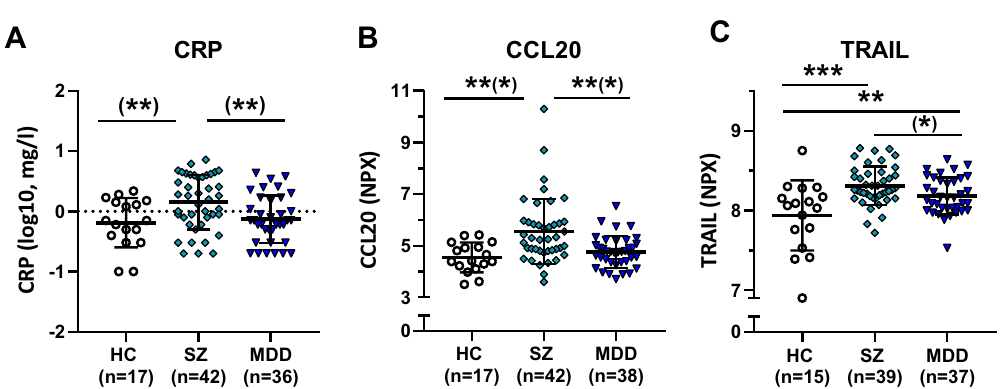
Figure 1. Group comparison of inflammatory markers. ( A ) CRP (log), ( B ) CCL20, ( C ) TRAIL. Units are mg/l for log10 (CRP), otherwise normalized protein expression (NPX) (an arbitrary unit on a log2-scale where a high value corresponds to a higher protein expression). HC healthy control, MDD major depression disorder, SZ schizophrenia, CRP C-reactive protein, CCL C–C chemokine ligand, TRAIL TNF (tumor necrosis factor)- related apoptosis-inducing ligand. Mean and standard deviation (SD) are depicted. After post-hoc comparison (FDR): *p ≤ 0.05, **p ≤ 0.01, ***p ≤ 0.001; asterisks in brackets indicate changes in significance after introducing BMI, sex and smoking as